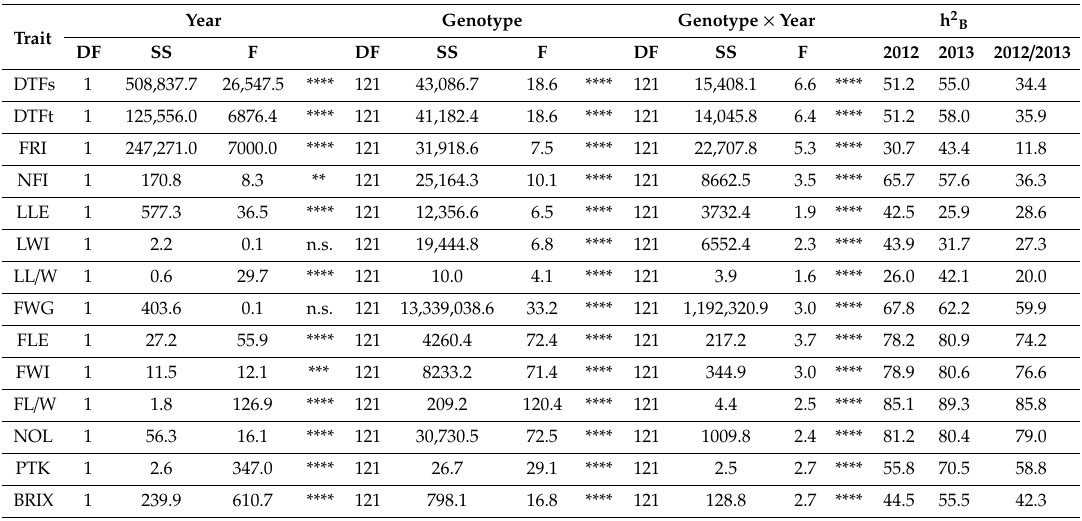
Table 1. ANOVA analysis performed across 122 tomato accessions for 14 conventional quantitative traits evaluated in 2012 and 2013. Year ( Y ), genotype ( G ) and genotype × year ( G × Y ) interactions were considered as e ff ects of the